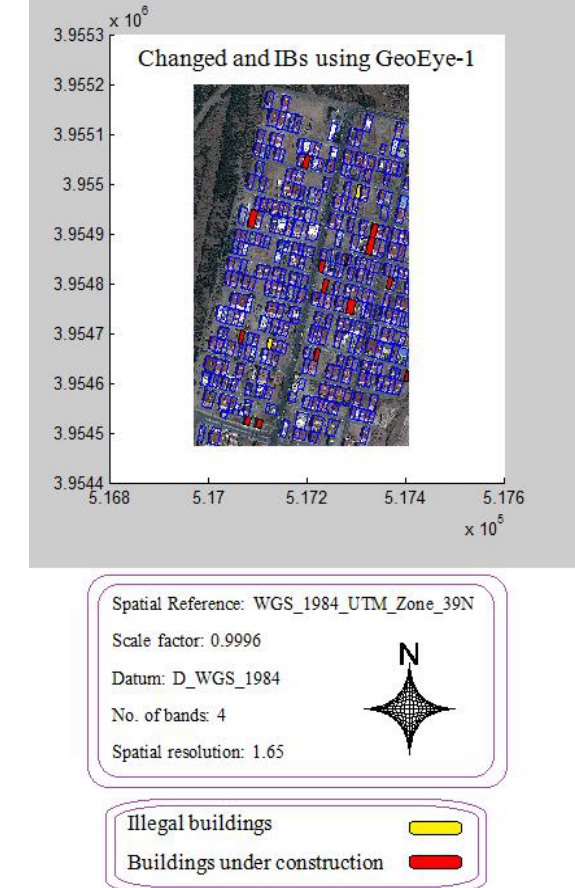
Figure 8. The produced change image map using QuickBird satellite images Figure 9. The detected under construction buildings and IBs using GeoEye-1 satellite